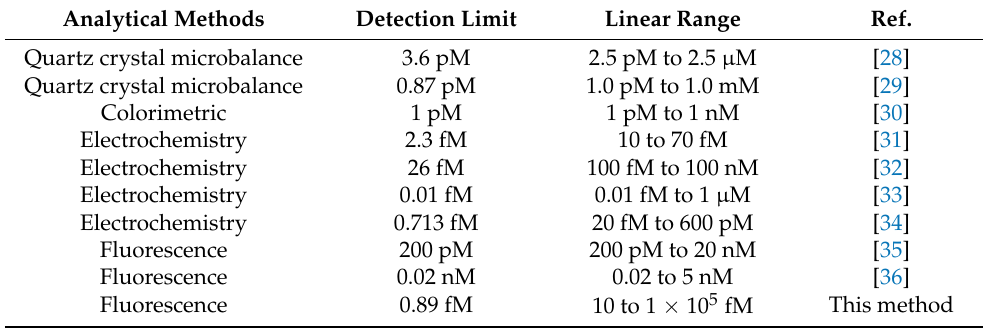
Table 1. Comparison of miR-21 detection with the reported methods.